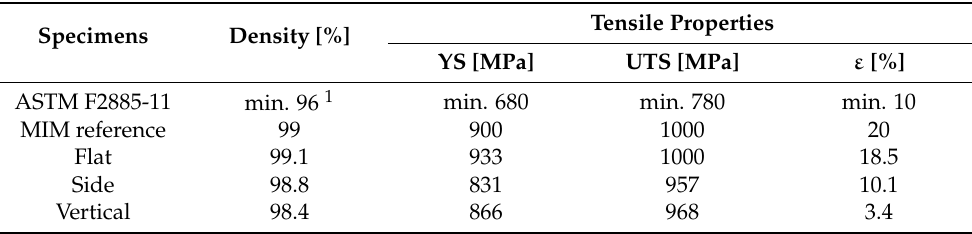
Table 4. Comparison of the additively manufactured specimens in orientation flat, side, and vertical with ASTM F2885-11 and MIM reference in terms of part density and tensile properties.